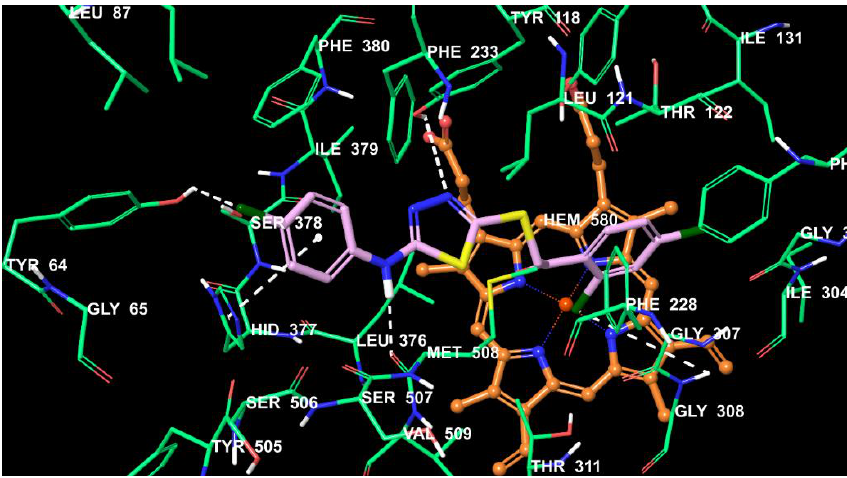
Figure 6. Active compound 3l in the active region of 14- α -sterol demethylase (PDB code: 5FSA). The inhibitor is colored pink and the heme molecule is colored orange. Molecules 2018 , xx , x FOR PEER REVIEW